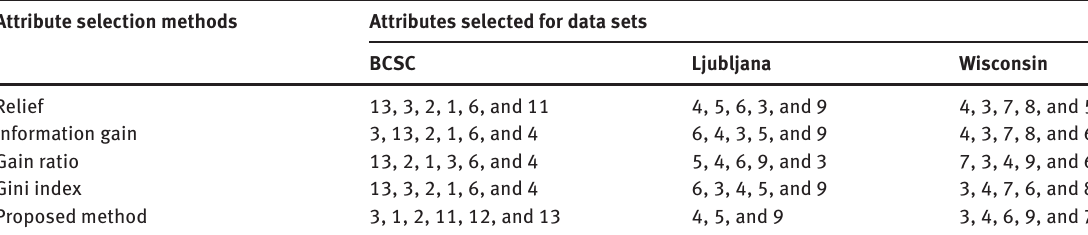
Table 7: Selection of Top N Attributes from Various Feature Selection Methods. Attribute selection methods